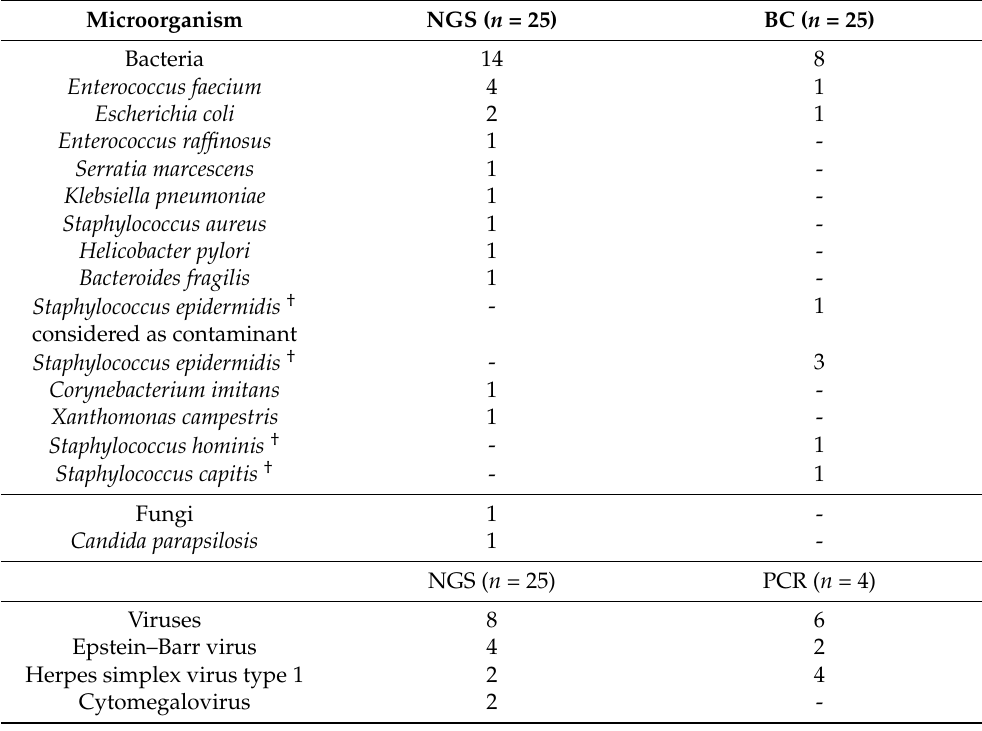
Table 2. Microorganisms detected by NGS, BC, and PCR. NGS detected 23 isolates (14 bacteria, 1 fungus, and 8 viruses) and provided positive results in 52% (13/25) of cases, whereas BC identified eight bacteria in 28% (7/25) of cases. The most frequently detected bacteria were Enterococcus species in NGS and coagulase-negative staphylococci in BC. Following the identification of viruses by NGS, PCR confirmed four out of five viruses and detected two further isolates of HSV-1. † Coagulase- negative staphylococci. BC: blood culture; HSV-1: herpes simplex virus type 1; NGS: next-generation sequencing; PCR: polymerase chain